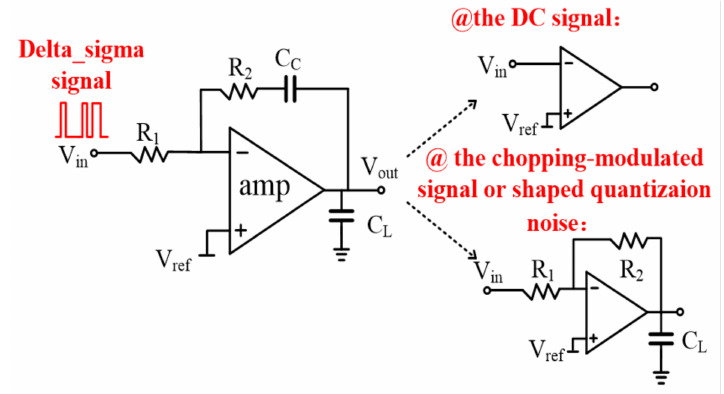
Figure 13. Analog filtering implementation.